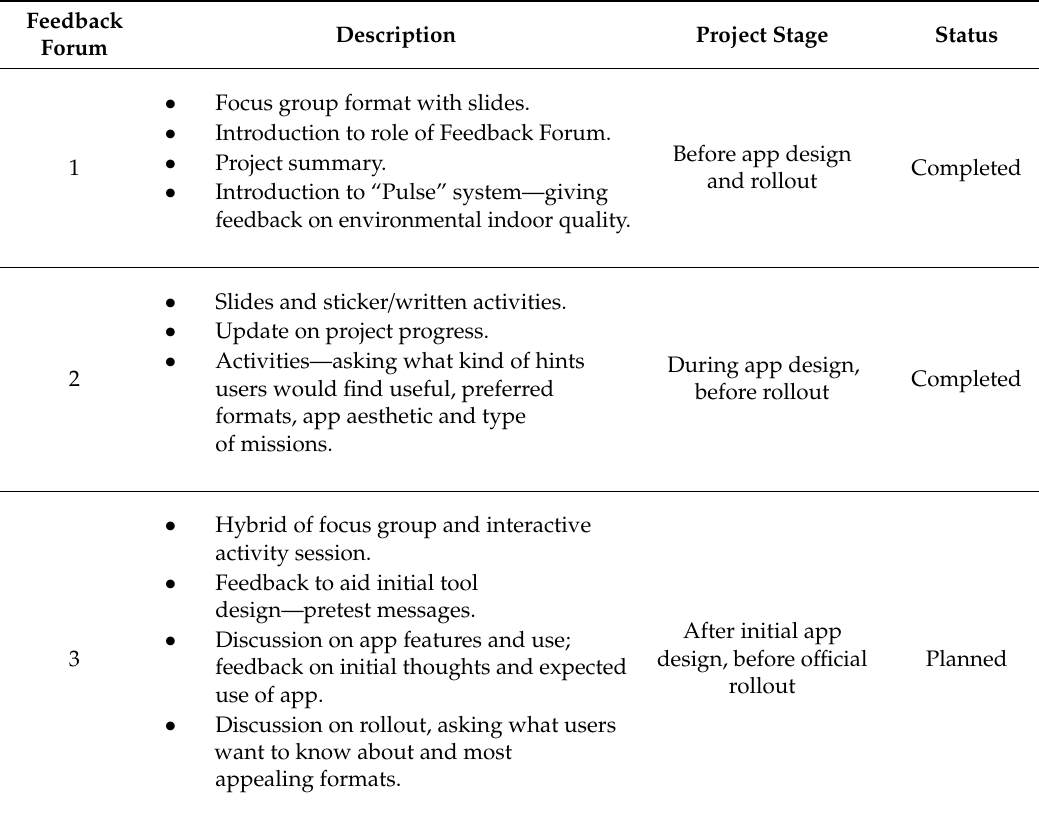
Table 6. Feedback forums and project